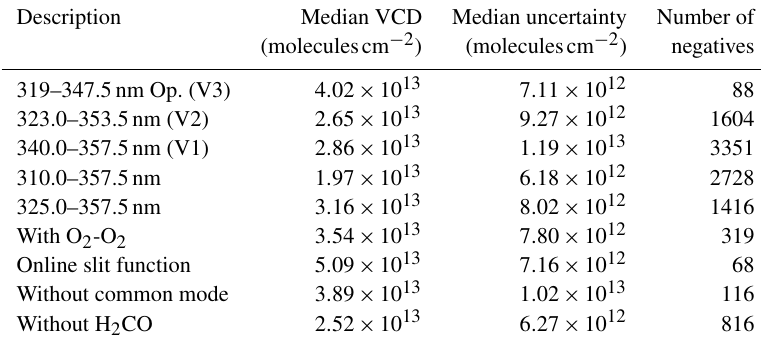
Table 2. Error analysis studies. For reference, the total number of retrieved pixels not affected by the row anomaly is 58112.